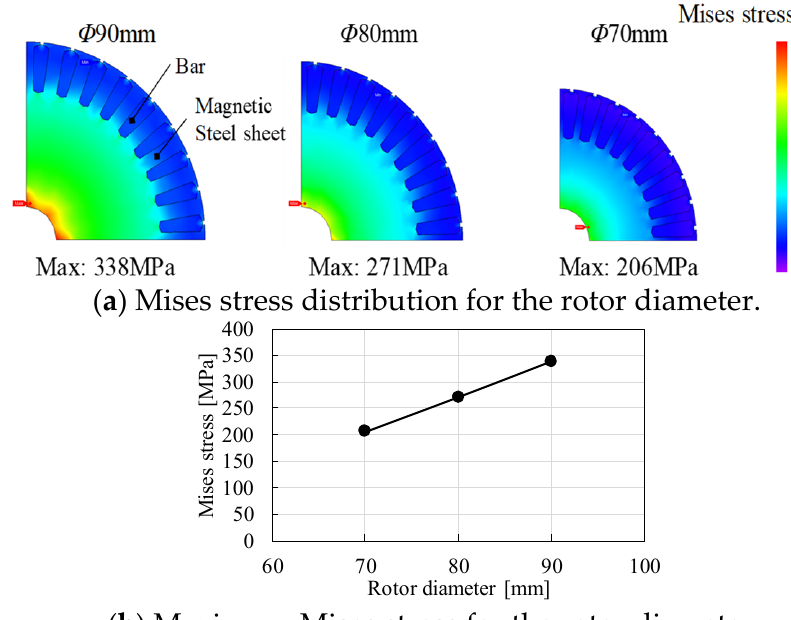
Figure 16. Mises stress of IM in the rotor at 52,000 min − 1 .